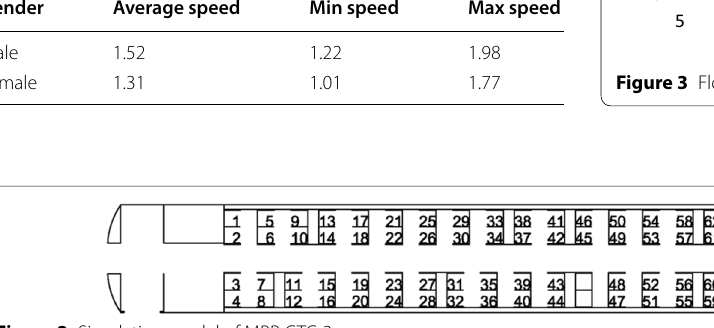
Figure 2 Simulation model of MBB CTC-3 car